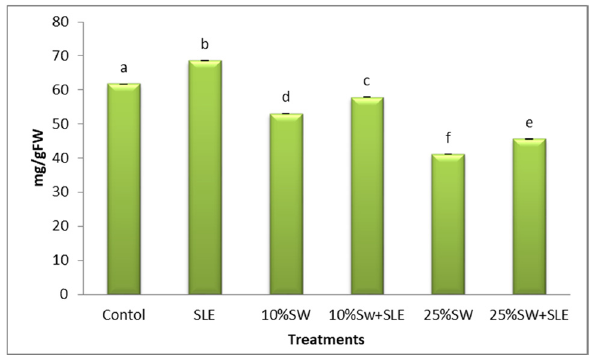
Figure 5: E ff ect of 2% SLE in protein contents of T. aestivum L. grown under salt stress. Control – tap water, SW – seawater, SLE – spirulina liquid extracts 2%. The di ff erent letters are signi fi cant ( P ≤ 0.05 ) according to Duncan ’ s multiple range